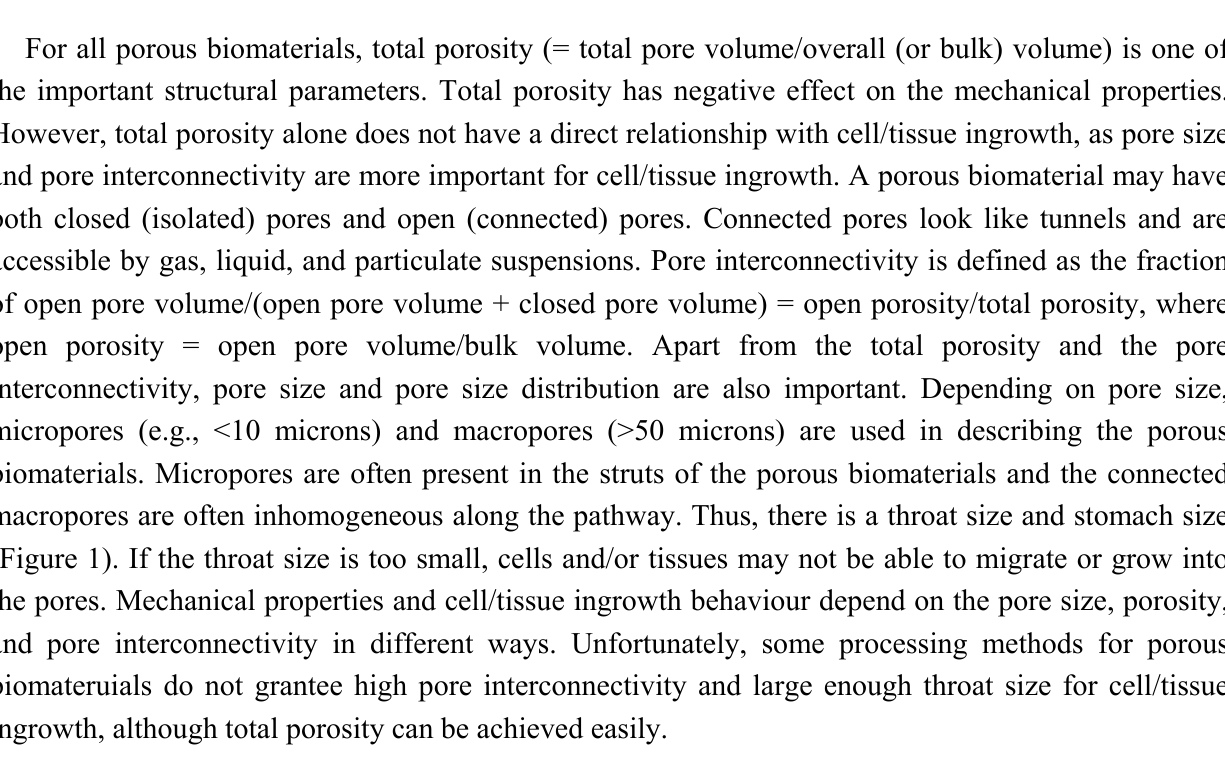
Figure 1. Schematic illustration showing the porous features of a porous